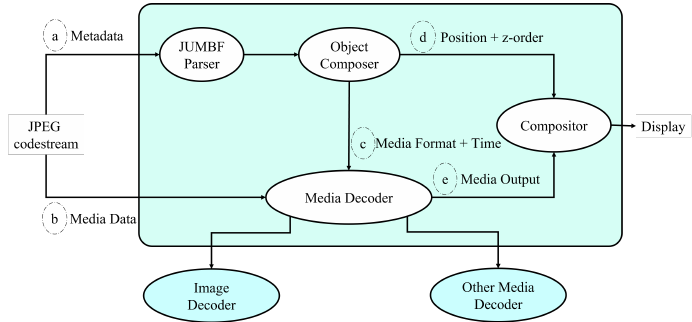
Figure 5. Components of JPEG Snack System